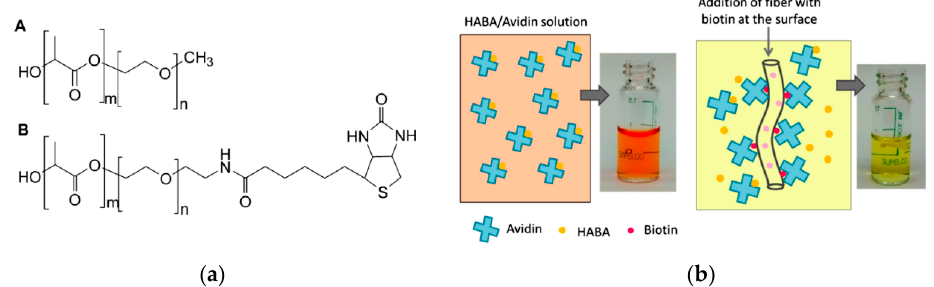
Figure 11. Molecular structures of PLA-b-PEG and PLA-b-PEG-Biotin copolymers ( a ), illustration of PLA/PLA-b-PEG/Biotin nanofibers for the removal of avidin from a 4 ′ -hydroxyazobenzene-2-carboxylic acid (HABA)/Avidin solution ( b ). Initially, avidin and HABA form a complex with an orange color. When nanofibers containing biotin are added to the solution, avidin binds biotin, breaking the HABA / avidin complex and leading to a color change. (Reproduced with permission from [74]. Copyright American Chemical Society,